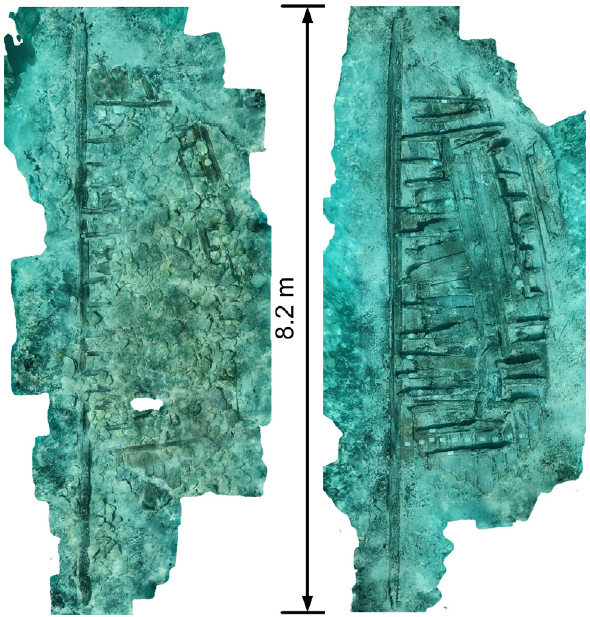
Figure 14. Ortho-photographs generated from the image-based 3D models: left) site before stratigraphic excavation-the small hole represents missing 2D images, right) site after excavation.